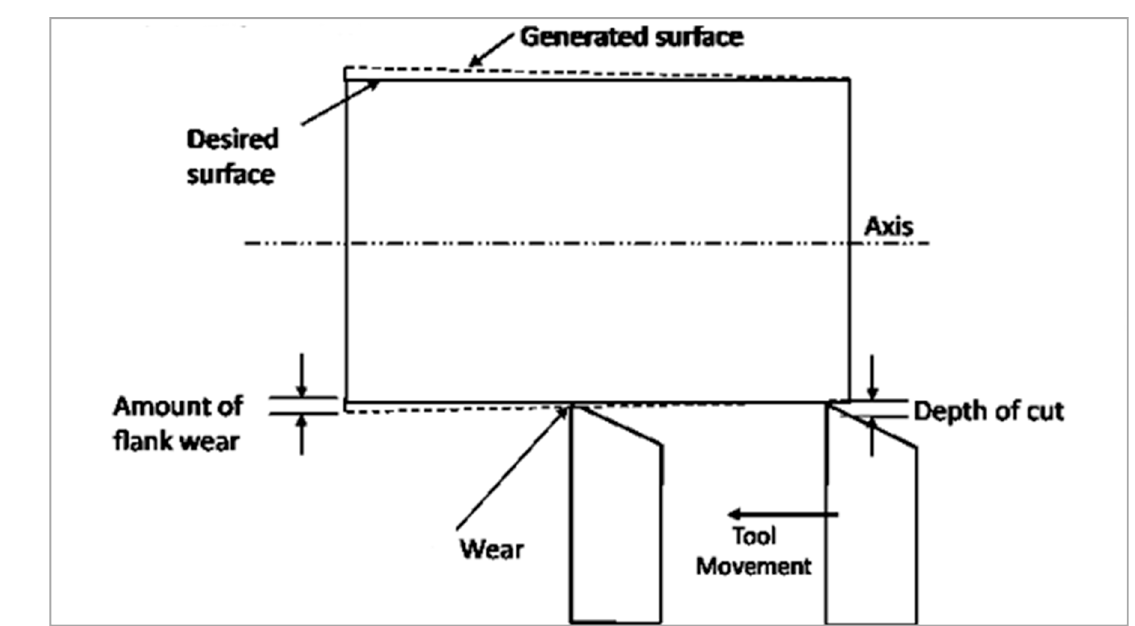
Figure 11. Effect of tool wear on the machined surface.